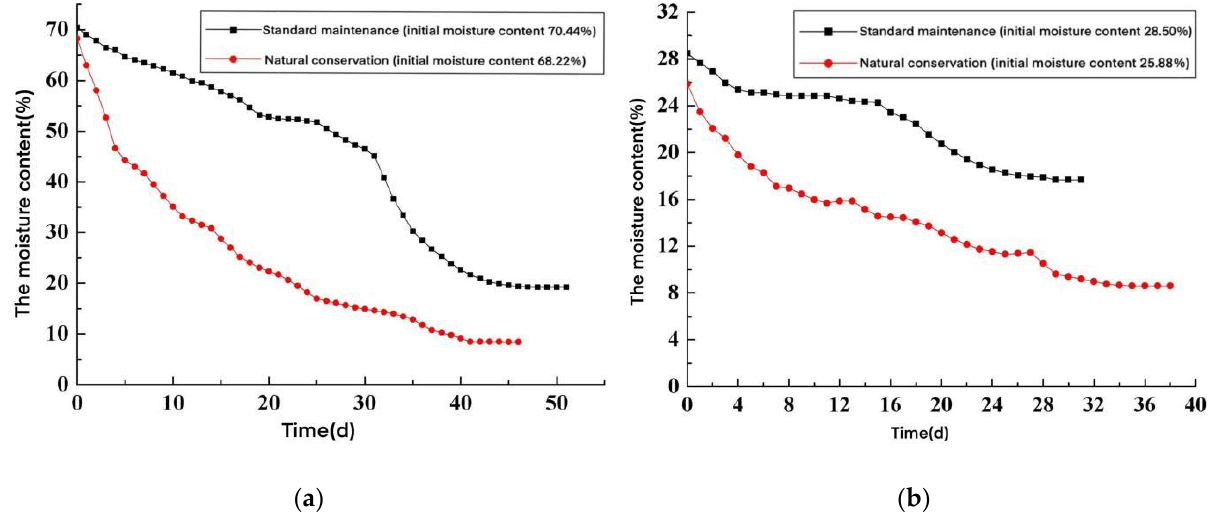
Figure 5. Curve of test moisture content with time. ( a ) Saturated moisture content state and ( b ) moisture content after one day out of the kettle